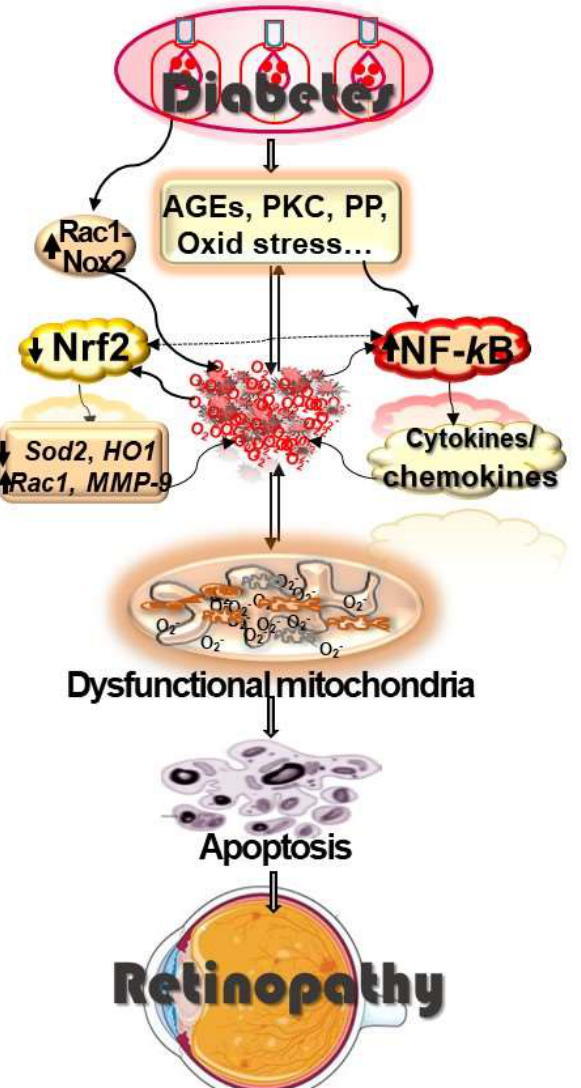
Figure 1. Diabetes alters the activity of many metabolic pathways (AGEs, PKC, polyol pathway, PP), and activation of these metabolic pathways produces ROS; conversely, ROS also activate these pathways. In addition, Rac-Nox2 signaling is activated, which adds to the increase in cytosolic ROS. The transcriptional activity of Nrf2 is decreased, but that of NF- k B is increased. Inhibition of Nrf2 transcriptional activity leads to a suboptimal antioxidant defense system, and via NF- k B, to the production of inflammatory cytokines, further contributing to increase in oxidative stress and inflammation. Activation of NF- k B increases inflammatory cytokines/chemokines, and these inflammatory mediators further fuel ROS production. NF- k B activation also transcriptionally ac- tivates ROS, producing Rac1 and MMP-9 and suppressing ROS-quenching Sod2 . Cytosolic ROS damage the mitochondria, and the dysfunctional mitochondria accelerate capillary cell apoptosis, resulting in degenerative capillaries and pericyte ghosts. This ultimately leads to the development of diabetic